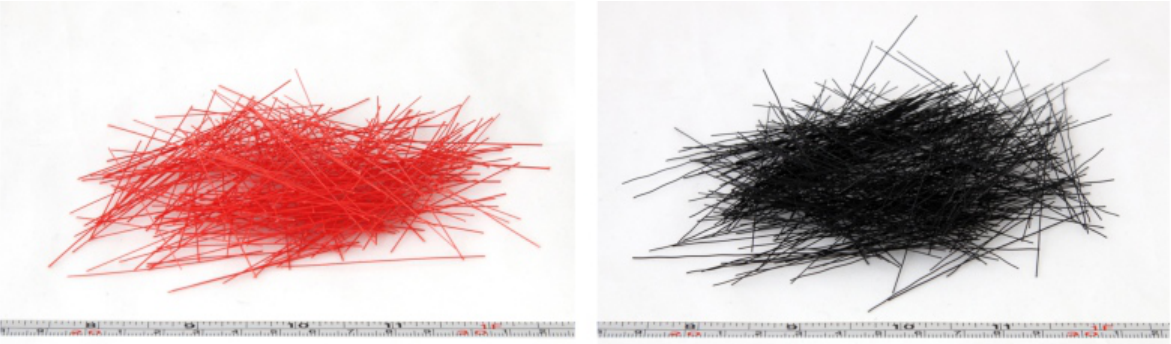
Figure 1. Digital camera photo of PET (left), PP fibers